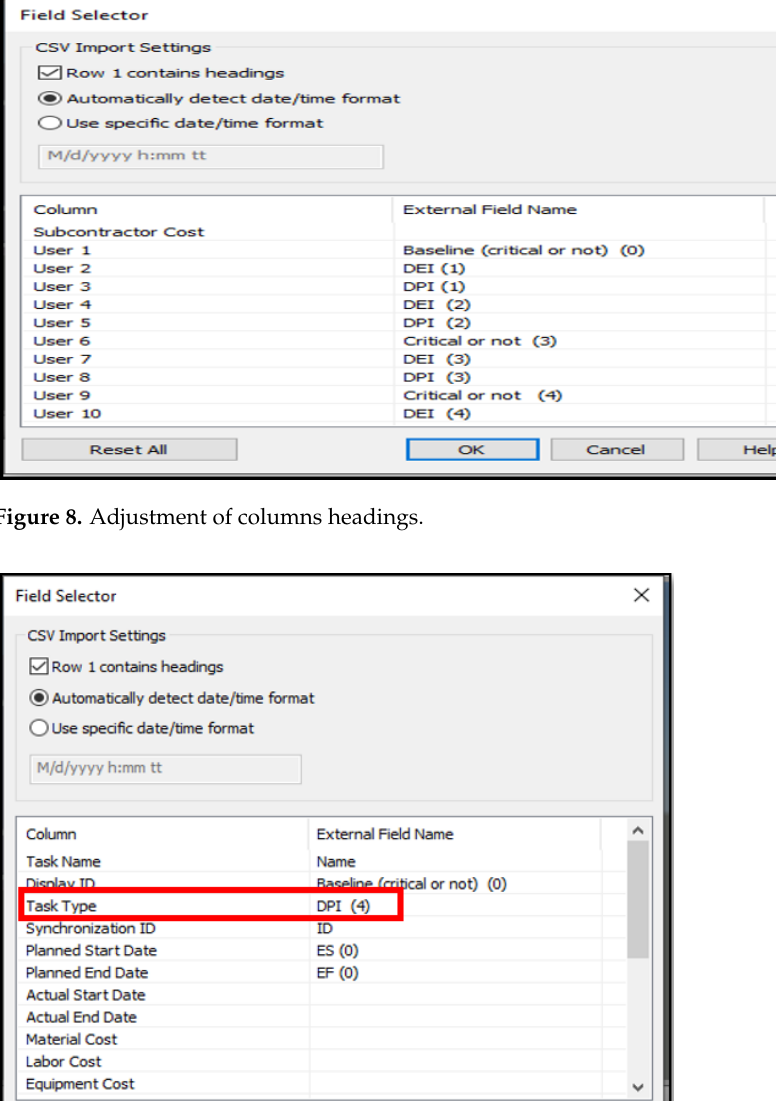
Figure 9. Adjusting the task